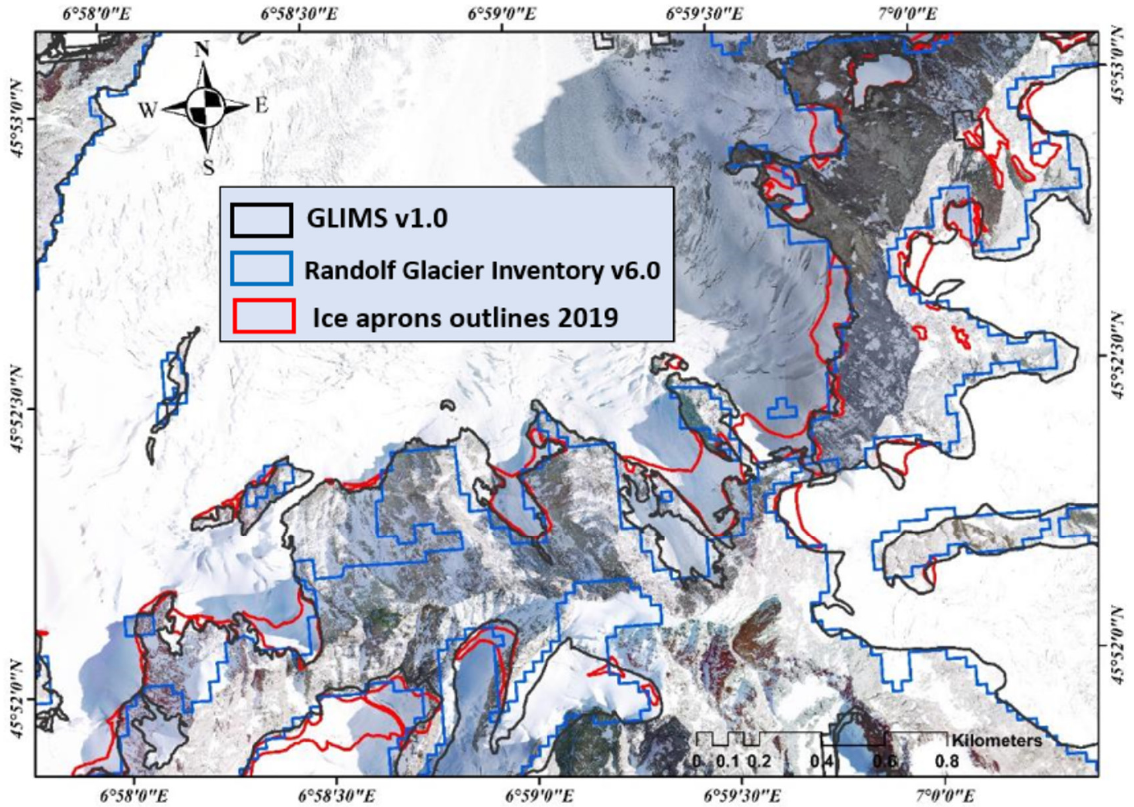
Figure 2. Comparison of global glacier inventories in the MBM (green box in Figure 1). The ice aprons (IAs) were delineated using high-resolution optical/aerial photographs from 2019. The RGI outlines v6.0 (blue) refer to the year 2003 [44], while the latest GLIMS outlines v1.0 (black) are for the year 2011 (submitter: Claudio Smiraglia, Università degli Studi di Milano).